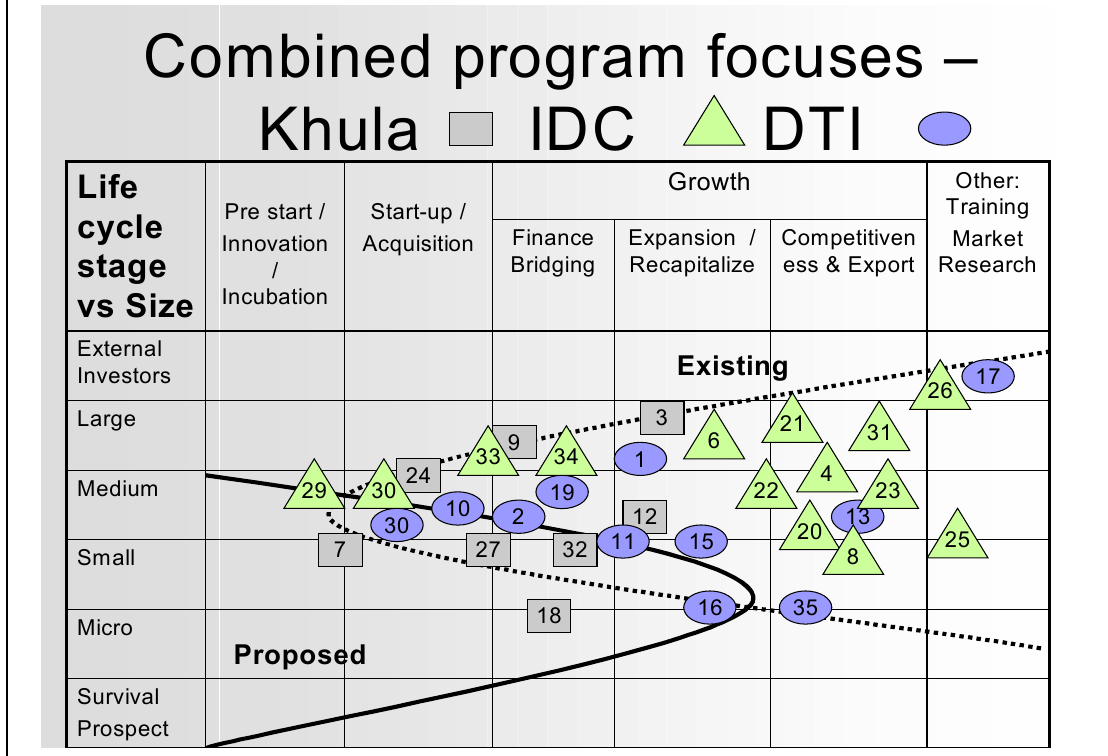
Figure 2 Graphical presentation showing that the program focuses of IDC, DTI, and Khula programs lean towards larger ventures and growth rather than SMME and start-ups (own